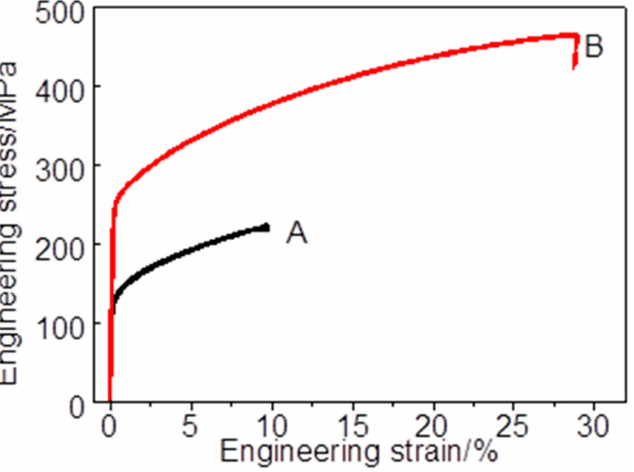
Figure 6. Curves A and B are tensile engineering stress–strain curves of as-cast Cu-10Sn-2Zn and Cu-10Sn-2Zn-1.5Fe-0.5Co alloys, respectively [48]. Chen et al. [69] studied as-cast Cu-12Sn-1.5Ni bronze alloys with different iron contents (0, 0.053, 0.63 and 1.44 wt.% Fe). The individual addition of iron also induces the formation of NPFG structure and the elimination of coarse segregation phase. In the original Cu- 12Sn-1.5Ni, the dendrites of α -Cu phase are very coarse (Figure 7a,b), while the grains of Cu-12Sn-1.5Ni- x Fe alloys with different iron contents have refined (Figure 7c–h).